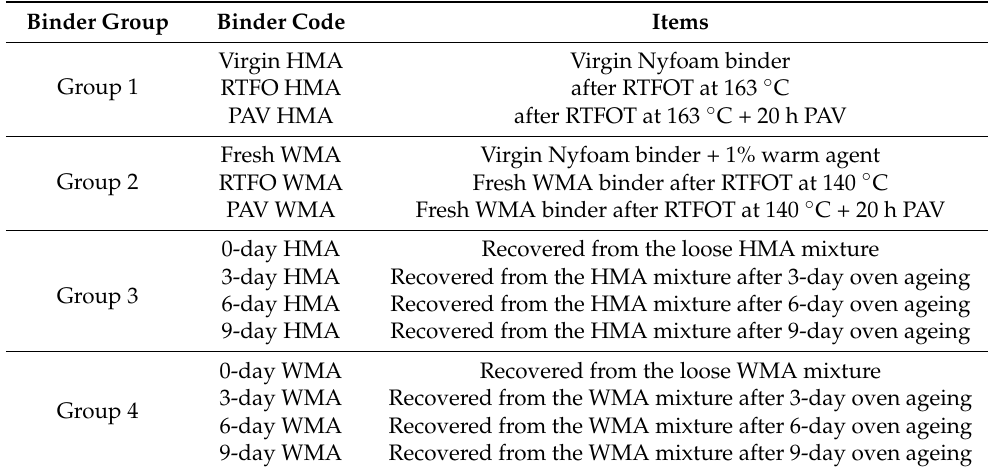
Figure 1. The illustration on the ageing protocols for the HMA and WMA mixtures. Table 1. Codes for the binder samples before and after ageing. Binder Group